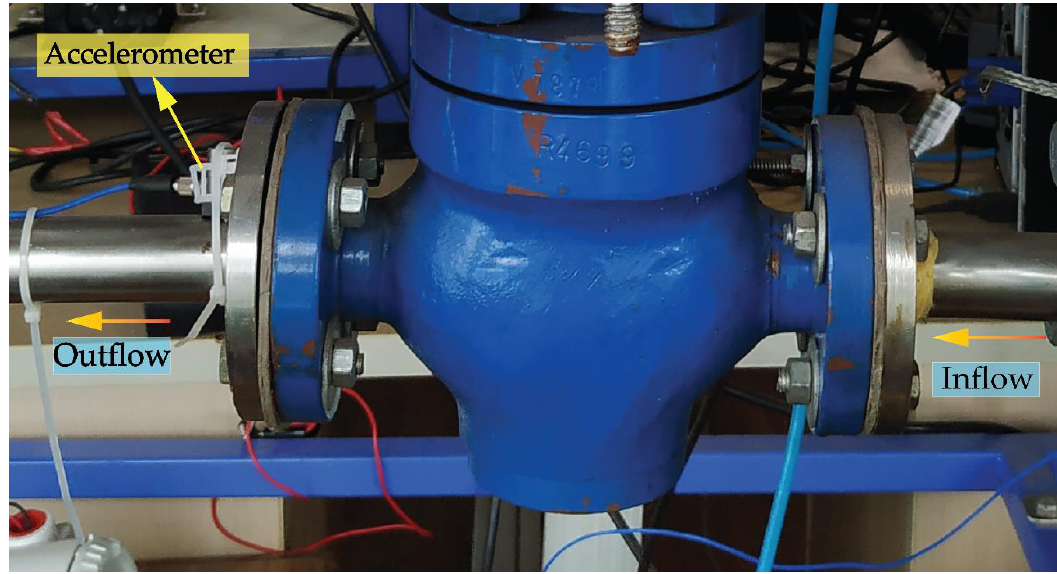
Figure 5. Placement of accelerometer to capture vibration signal .